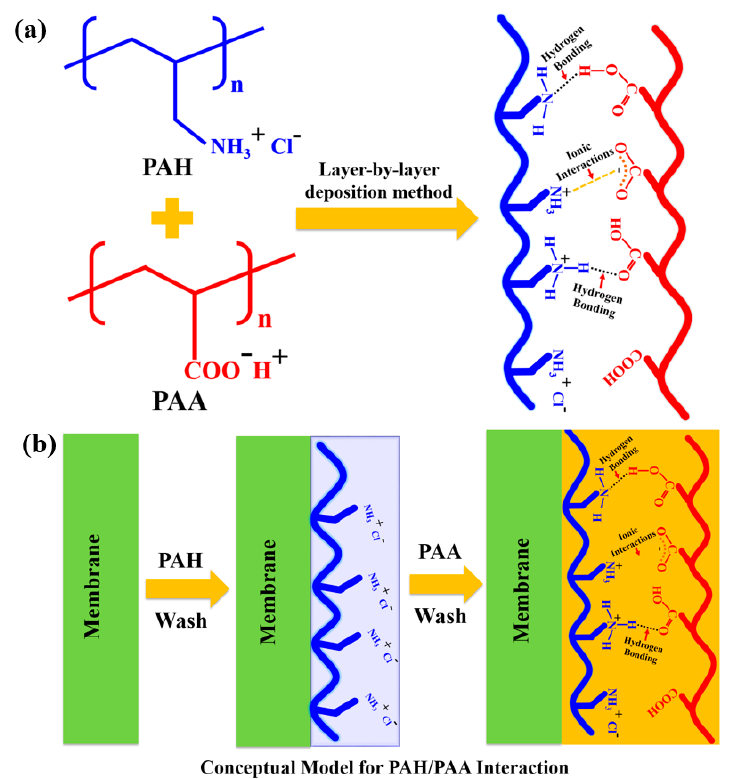
Figure 2. ( a ) Conceptual model for possible interactions of the PAA and PAH before and ( b ) LBL deposition on NF90 membrane.